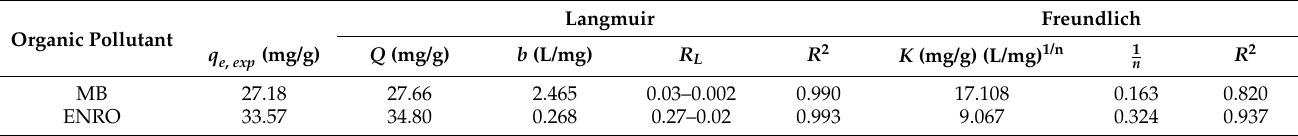
Table 1. Parameters of the isotherm models for MB and ENRO adsorption onto HNC, in single system, expressed in linear